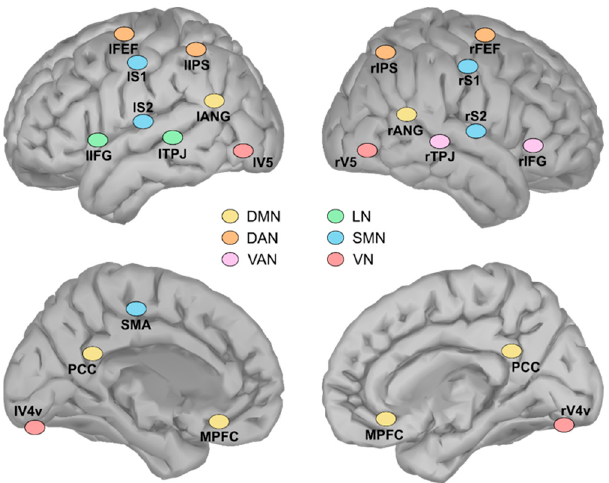
Figure 1. Anatomical positions of the 21 seeds used for analysis, subdivided into the corresponding networks. Default mode network (DMN): posterior cingulate cortex (PCC), medial prefrontal cortex (MPFC), left/right angular gyrus (lANG/rANG); Dorsal attention network (DAN): left/right frontal eye field (lFEF/rFEF), left/right inferior parietal sulcus (lIPS/rIPS); Ventral attention network (VAN): right temporo-parietal junction (rTPJ), right inferior frontal gyrus (rIFG); Language network (LN, green): left temporo-parietal junction (lTPJ), left inferior frontal gyrus (lIFG); Somatomotor network (SMN): supplementary motor area (SMA), left/right primary somatosensory cortex (lS1/rS1), left/right secondary somatosensory cortex (lS2/rS2); Visual network (VN): left/right human ventral visual area 4 (lV4v/rV4v), left/right visual area 5 (lV5/rV5).